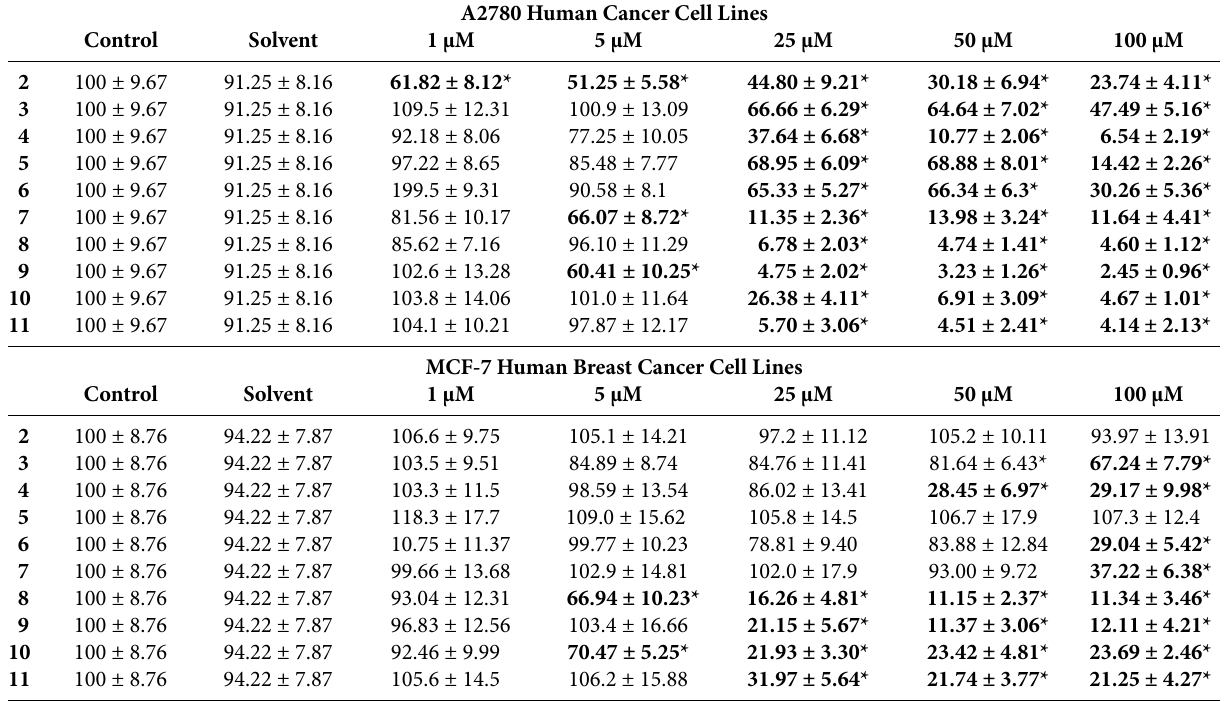
Table 1. Cell viability (in %) of compounds 2 – 11 against human cancer cell lines ( p * < 0.05). A2780 Human Cancer Cell